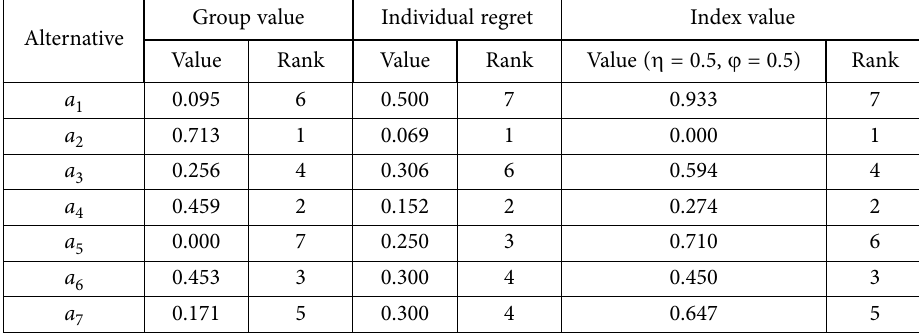
Table 7. The group values and individual regrets of alternatives obtained by the method in M. Lin et al. (2021a) Group value Individual regret Index value Alternative Value Rank Value Rank Value ( h = 0.5, j =